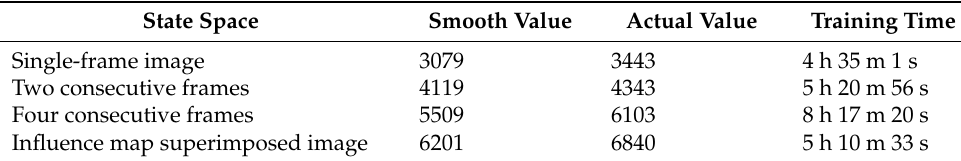
Figure 6. Training scores of four different image state spaces. Table 6. Ordinate comparison of four training scores at 1.2 M gradient descent.